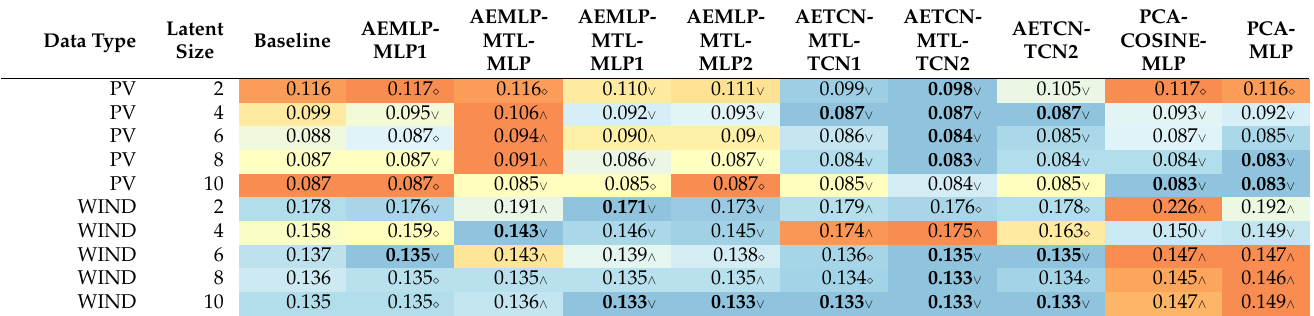
Table 8. Median nRMSE of the forecast error for best models and latent sizes for the autoencoder models (see Table 2), and the PCA-based models. AEMLP-MTL-MLP is the baseline and all models were tested to determine whether the mean performance rank is significantly better ( ∨ ), worse ( ∧ ), or not significantly different ( (cid:5) ) compared to the baseline. We tested for a significant difference with the Wilcoxon test ( α = 0.01). The colors denote the respective rank. Blue indicates a smaller (better) rank and red a higher (worse) rank. The best latent size and data type model is highlighted in